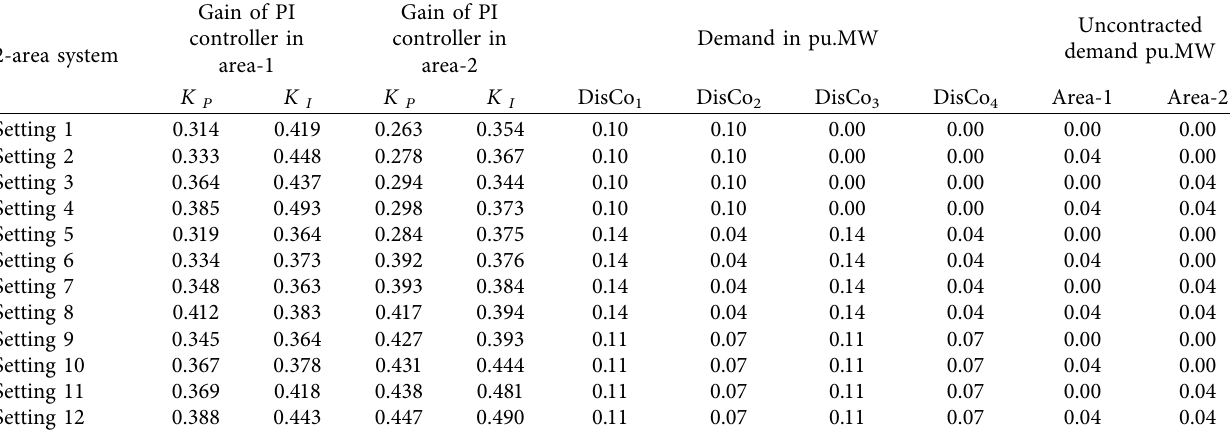
Table 1: Optimized PI controller gains for the power system under investigation.